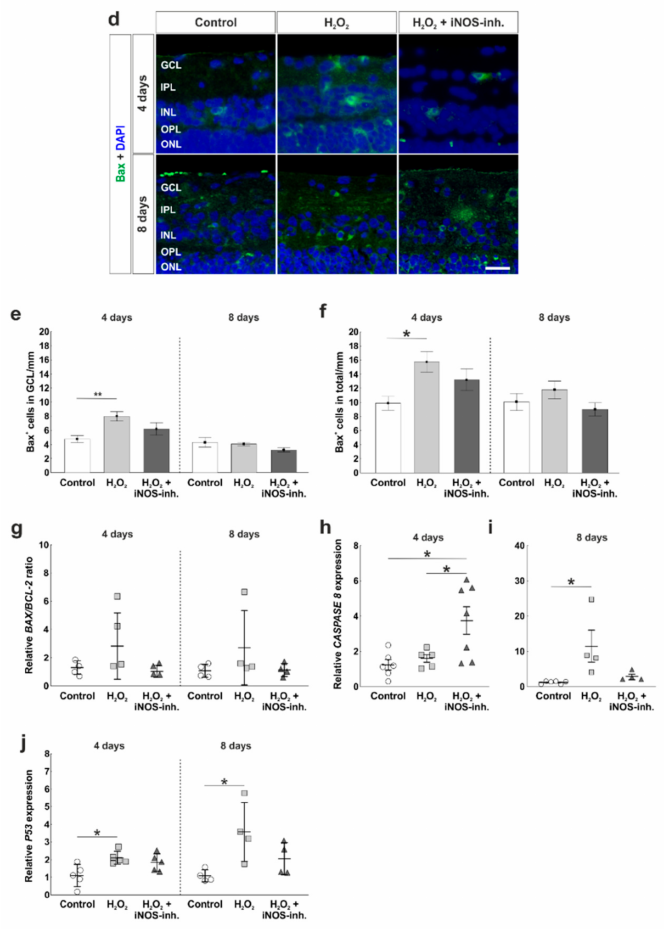
Figure 4. Less apoptosis in iNOS-inhibitor treated retinas. ( a ) Apoptotic cells were stained with cleaved caspase 3-antibodies (red). Cell nuclei were labelled with DAPI (blue). ( b ) A significantly increased number of apoptotic cells in the GCL was noted in H 2 O 2 -retinas at four ( p = 0.003) and eight days ( p = 0.03). Treatment with the iNOS-inhibitor prevented this increase. No differences were seen comparing the iNOS-inhibitor and the control group (four days: p = 0.32; eight days: p = 0.67). ( c ) Additionally, in the total retina, the number of cleaved caspase 3 + cells was elevated through oxidative stress ( p = 0.015), which was prevented by the iNOS-inhibitor ( p = 0.19). ( d ) Bax-antibodies were used to visualize apoptotic cells of the intrinsic pathway (green). Cell nuclei are shown by DAPI-staining in blue. ( e ) A higher number of Bax + cells was noted in the GCL of H 2 O 2 -retinas at four days ( p = 0.008). Treatment with the iNOS-inhibitor lowered the number of apoptotic cells, but this effect was not significant ( p = 0.33). ( f ) In the total retina, more Bax + cells were seen in H 2 O 2 -stressed retinas at four days ( p = 0.014). The iNOS-inhibitor had no effect on the number of Bax + cells ( p = 0.21). ( g ) Comparable expressions of BAX/BCL-2 ratio were noted in all groups. ( h ) A significantly increased mRNA expression of CASPASE 8 was seen in iNOS-inhibitor treated groups (to control retinas: p = 0.015) to H 2 O 2 : p = 0.048). ( i ) At eight days, the expression of CASPASE 8 mRNA due to H 2 O 2 ( p = 0.018) was totally counteracted by the iNOS-inhibitor. ( j ) P53 expression was significantly increased after oxidative stress in both points in time (four days: p = 0.022; eight days: p = 0.028). The iNOS-inhibitor tended to reduce the expression of P53 toward the control level. GCL = ganglion cell layer; IPL = inner plexiform layer; INL = inner nuclear layer; OPL = outer plexiform layer; ONL = outer nuclear layer. ( a – f ) n = 9–10/group and ( g – i ) n = 4–8/group; scale bars = 20 µ m; values are shown as mean ± SEM for immunohistology and mean ± SD for RT-qPCR. * p < 0.05; ** p <